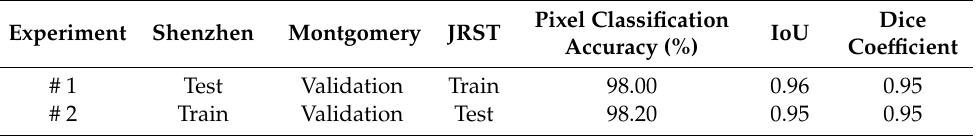
Table 3. Lung segmentation: performance analysis.